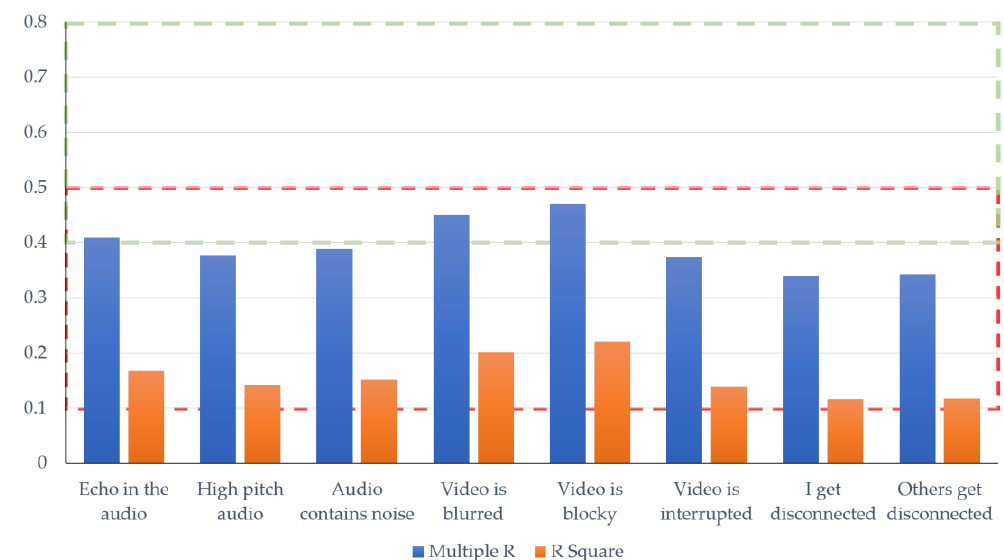
Figure 2. Multiple correlation coefficients (multiple R) and multiple coefficients of determination (R square). The green and red dashed rectangles represent moderate and weak correlations intervals, respectively. The overlapping between the rectangles indicates how different sources provide different interpretations of the intervals. Table 7. ANOVA table for all types of degradations.